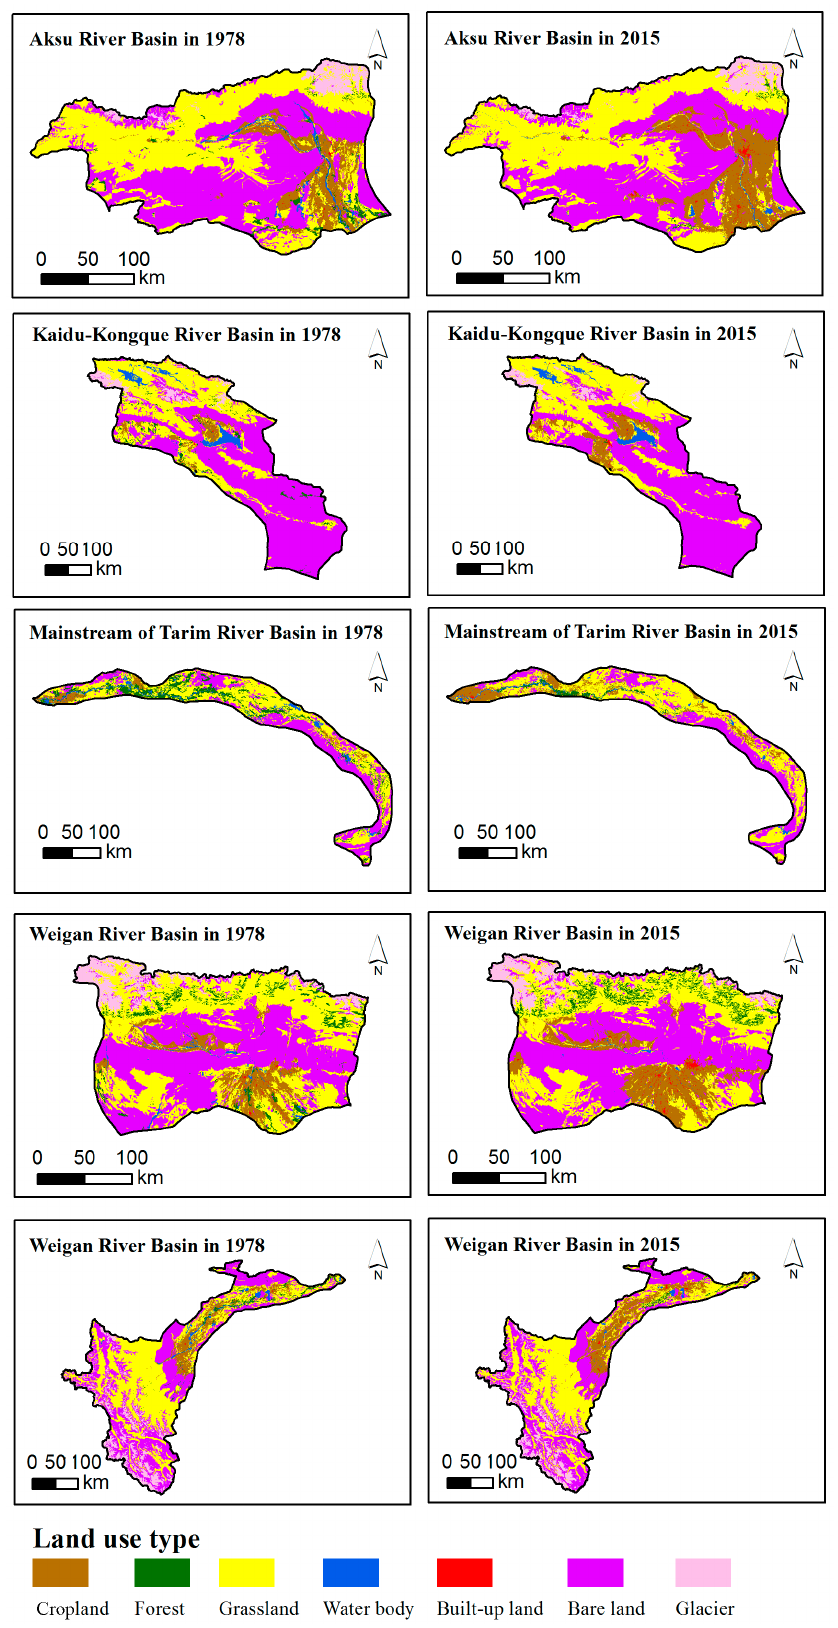
Figure 3. Land use maps of 1978 and 2015 in typical areas of the Tarim Basin.